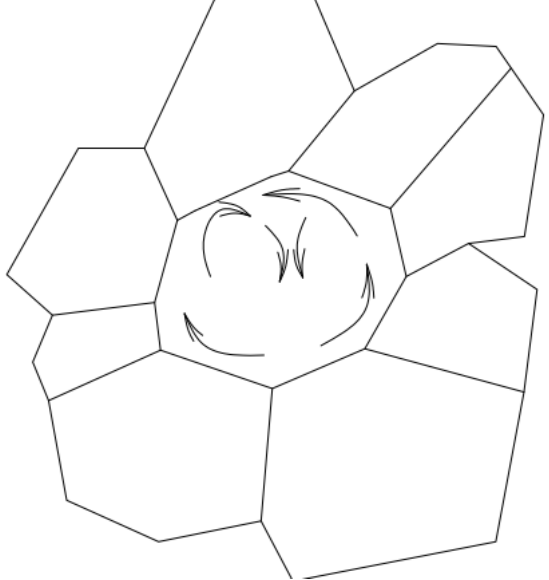
Figure 1. A picture of convective air currents inside a large closed cell.